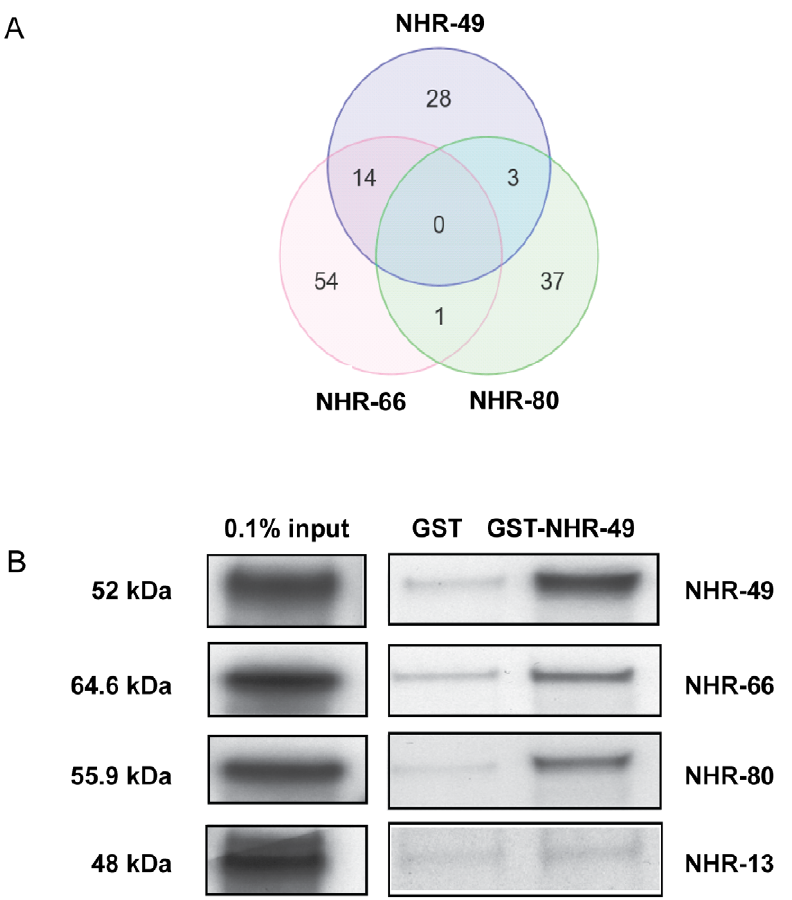
Figure 3. NHR-49 shares target genes and physically interacts with NHR-66 and NHR-80. (A) Venn diagram showing the comparison of genes regulated by NHR-49, NHR-66 and NHR-80. Gene identities are presented in Table S9. (B) NHR-49 physically interacts with NHR-49, NHR-66 and NHR-80 in vitro . Pull-down assays showing in vitro translated 35 S-methionine labeled NHR-49, NHR-66, NHR-80 and NHR-13 binding purified GST-NHR- 49 fusion protein versus purified GST-alone control. The protein mixtures of 35 S-methionine-labeled NHRs were incubated with glutathione- sepharose 4B beads and analyzed by SDS-PAGE (4–12%) followed by autoradiography. The input represents 0.1% of the labeled proteins used for the pull down